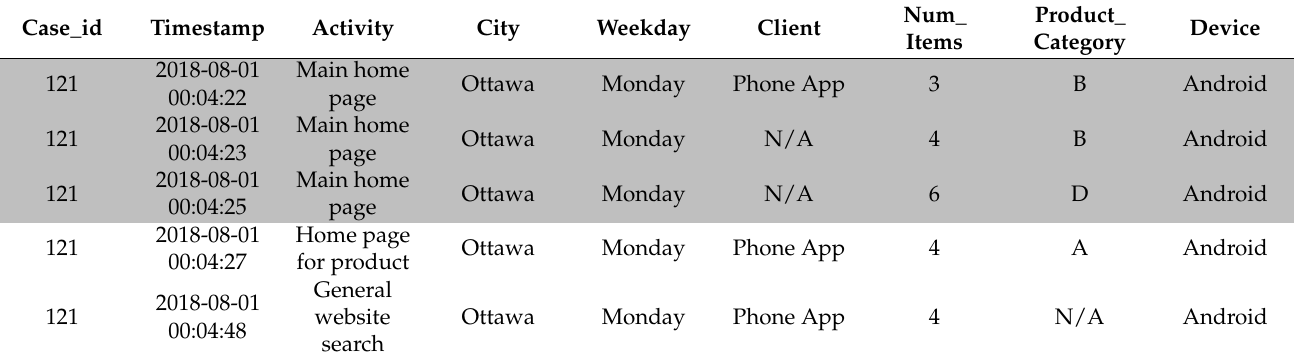
Table 1. Simple event log example, with targeted events to be merged highlighted in